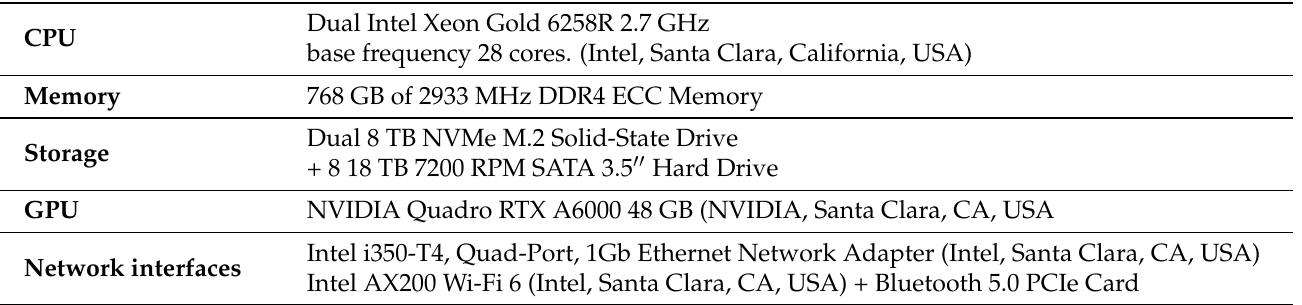
Table 2. Hardware platform